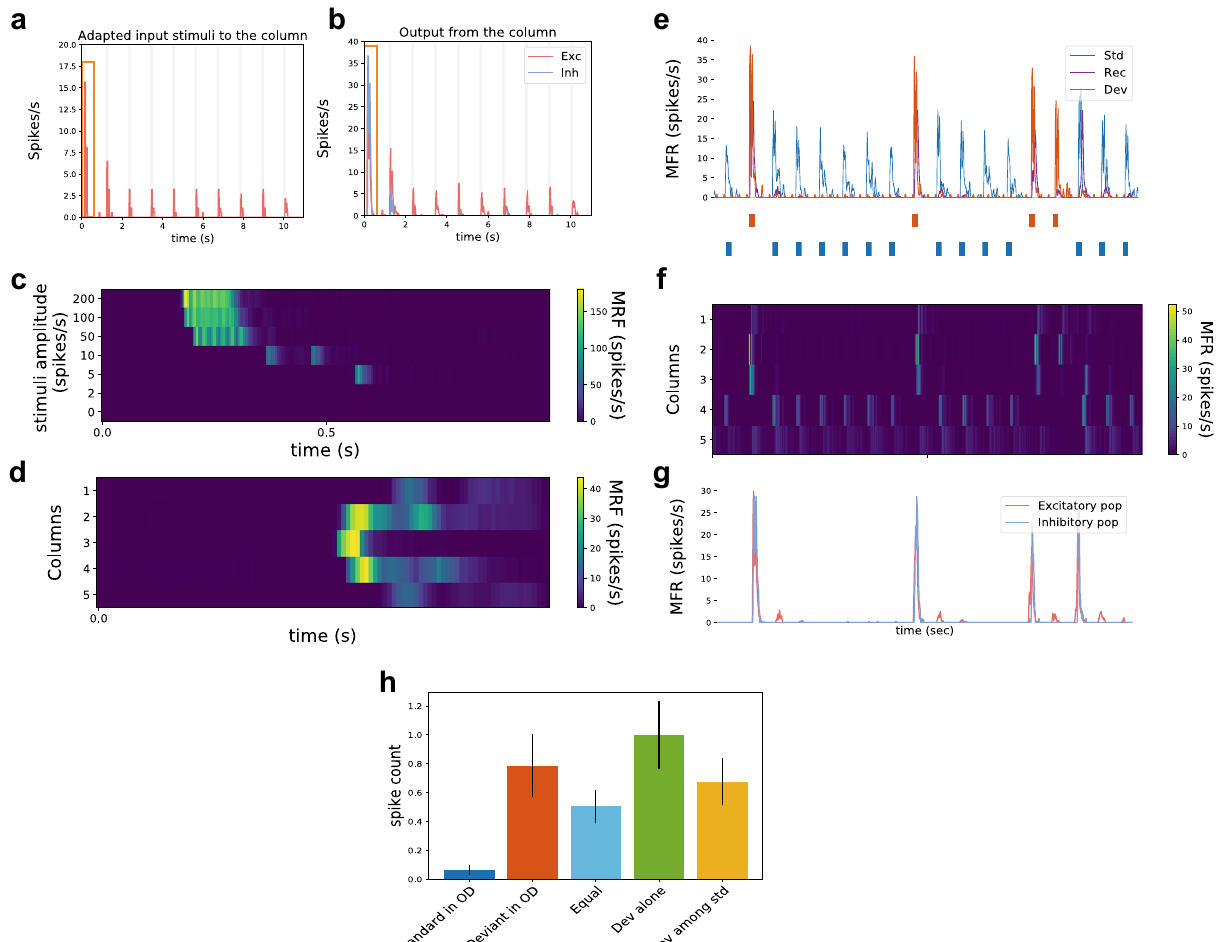
Figure 2. Neuromorphic implementation of SSA. Ten stimulations have been applied to the middle column to analyze our simulated-STD and the behaviour of a column in the network upon multiple stimulations. (a) represents the input coming to the column and (b) correspond to the output from the column. Synaptic depression has been previously shown to be key in the generation of PS and our model of spike frequency adaptation does simulate synaptic depression by the use of adapted inputs generated by the adaptive layer (a) . This results in an increase of the transient MRF upon presentation of the first stimulus (orange rectangle) which does not occur for the next presentations (b) . A PS appears upon the arrival of a stimulus and is represented by an increased MRF of the excitatory neuronal population in the column (red graph). The inhibitory population’s MRF (blue graph) increases only when a PS is generated and decreases through the course of the stimulation. Stimulus presentations (shown in gray) are of 100ms long followed by a pause of 900ms in between. (c) and (d) represents respectively the PS property and development in our network neuromorphic implementation. The time course of PS generation is depending on stimuli of varying amplitude and confirms the threshold for PS generation (c) . Below an input stimulus of 5 spikes/sec, no PS were generated. The color scale represents the response strength. A PS appears upon presentation of input spikes and propagates through the network. The columns’ population activity (d) and the oscilloscope traces (see Supplementary data S2) demonstrate the propagation of spikes from the column where spikes were sent to the two adjacent columns. Following is the study of the dynamics of the network population in response to an oddball paradigm. (e) The firing rate of the network population of three columns (Deviant column (Dev), Recording column (Rec) and, Standard column (Std)) during an oddball paradigm show the appearance of SSA. PS were usually observed upon presentation of the deviant (stimuli presentation shown in blue (standard) and red (deviant) under the plot). (f) Upon presentation of the deviant, PS are propagating to one column from each side while the standard does not generate a PS, due to the simulated-STD. (g) The behaviour of both populations (excitatory and inhibitory) in the recording column has been studied and the activation of the inhibitory population occurs only while the deviant is presented. (h) The averaged responses of the recording column (spike count) following the different control OD protocols (as in Fig. 1e) were analysed, with the total spike counts normalized to the Deviant Alone condition. Each protocol consisted of 100 stimuli presentations, repeated 10 times, with an ISI = 1 second and the bar height represents the mean spike count with standard error of the mean. Similar results were obtained between the mean-field rate modelling and the neuromorphic implementation showing a tendency towards true deviance